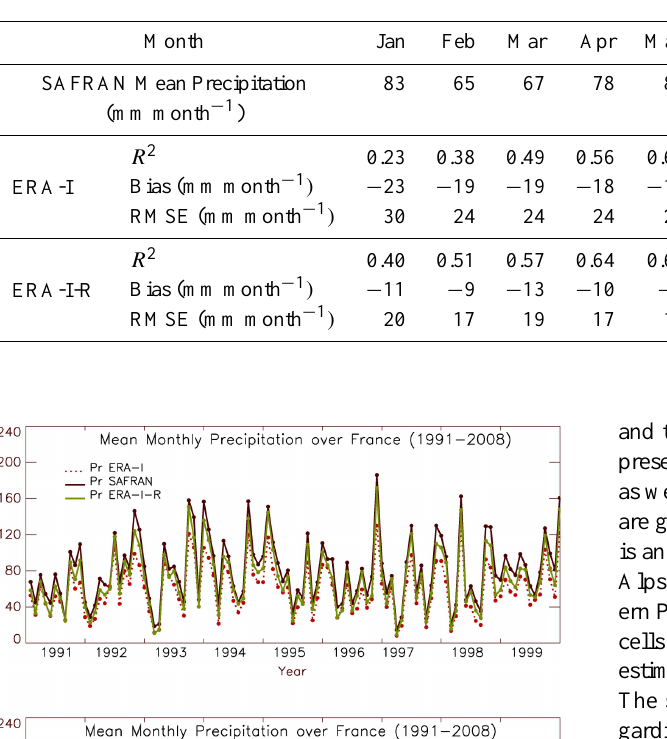
Table 2. Monthly precipitation over France for the 1991–2008 period as estimated by ERA-I and ERA-I-R vs. SAFRAN: performance of the spatial repartition of precipitation ( R 2 , mean bias (ERA-I/ERA-I-R minus SAFRAN) and RMSE, for 308 grid-cells).